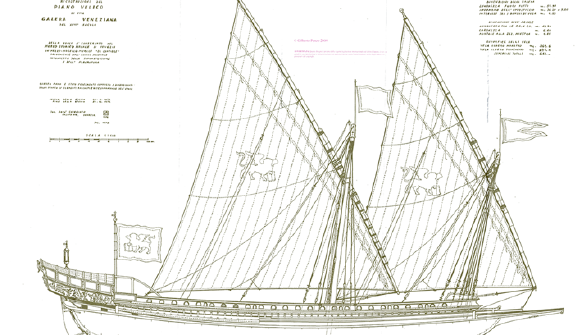
Figure 6. Cortelà’s mesh editing